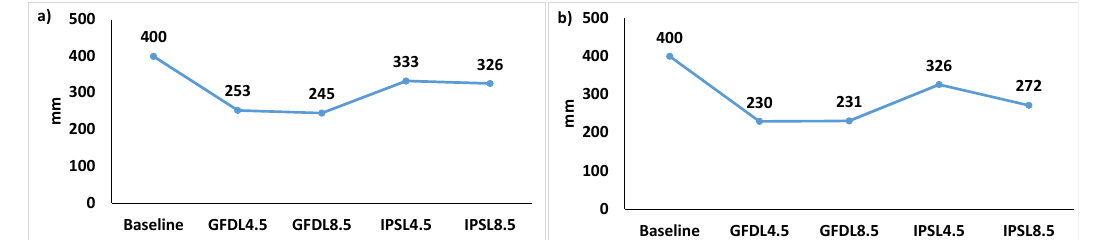
Figure 3. The annual average precipitation (mm) for the baseline conditions and climate scenarios: ( a ) timeline 2030; ( b ) timeline 2060. For clarification on the modelled scenarios, please see Figure 2.